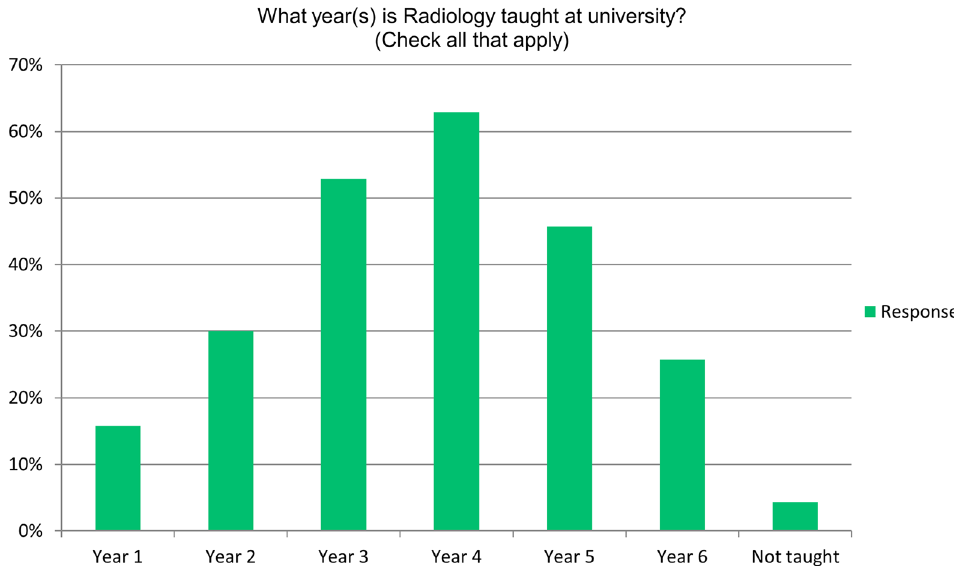
Fig. 1 Frequency plot showing distribution of radiology teaching across the year of medical school